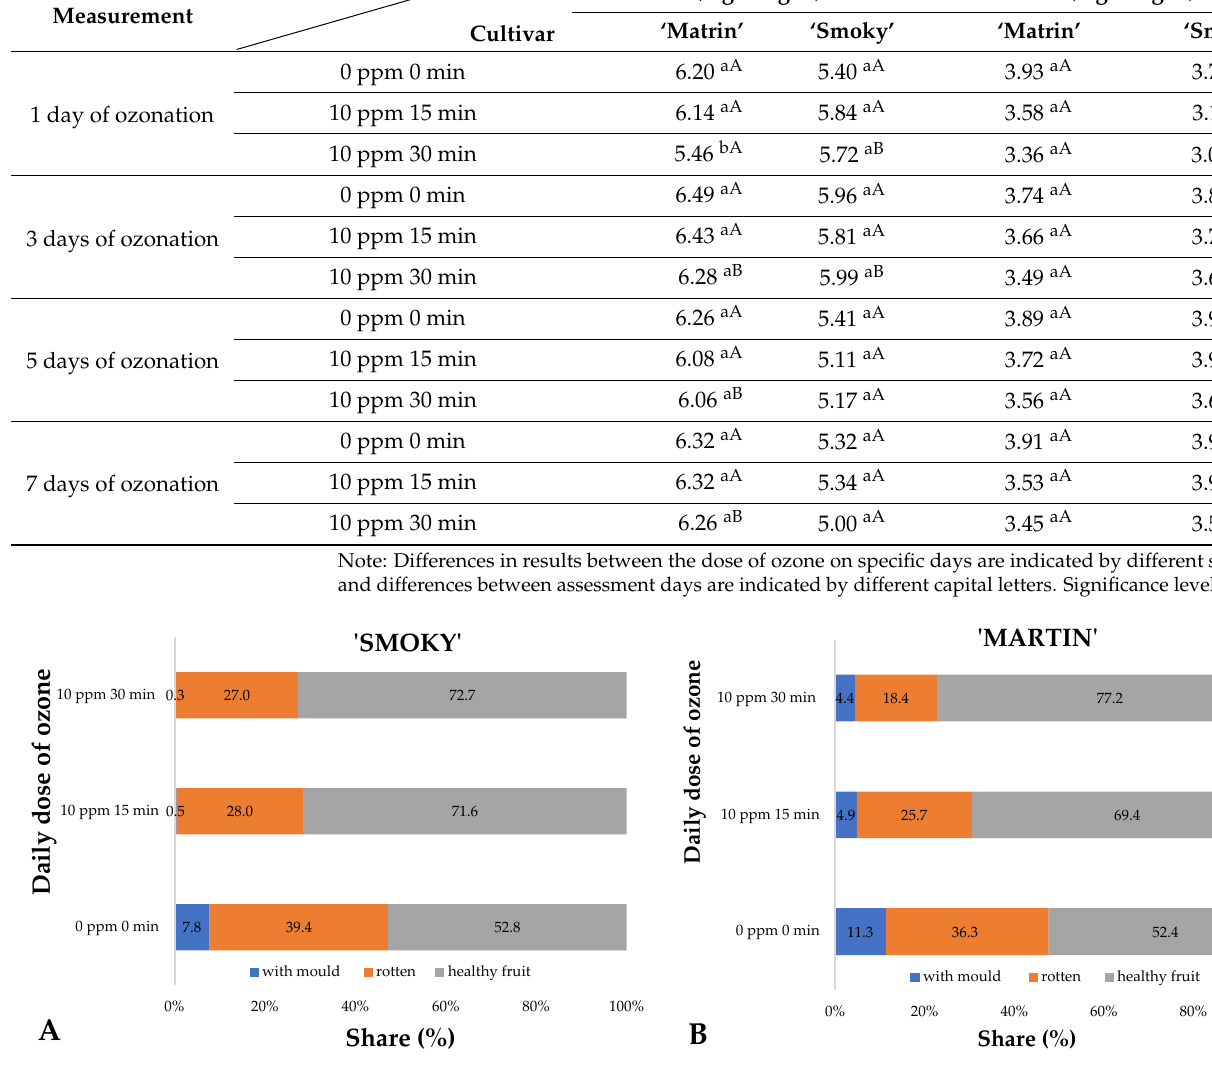
Figure 3. Mean rates of saskatoon berries of ‘Smoky’ ( A ) and ‘Martin’ ( B ) cultivars, infected with mould, rotting or healthy, in samples assessed on day 7 of the experiment, relative to the conditions of the ozone treatment